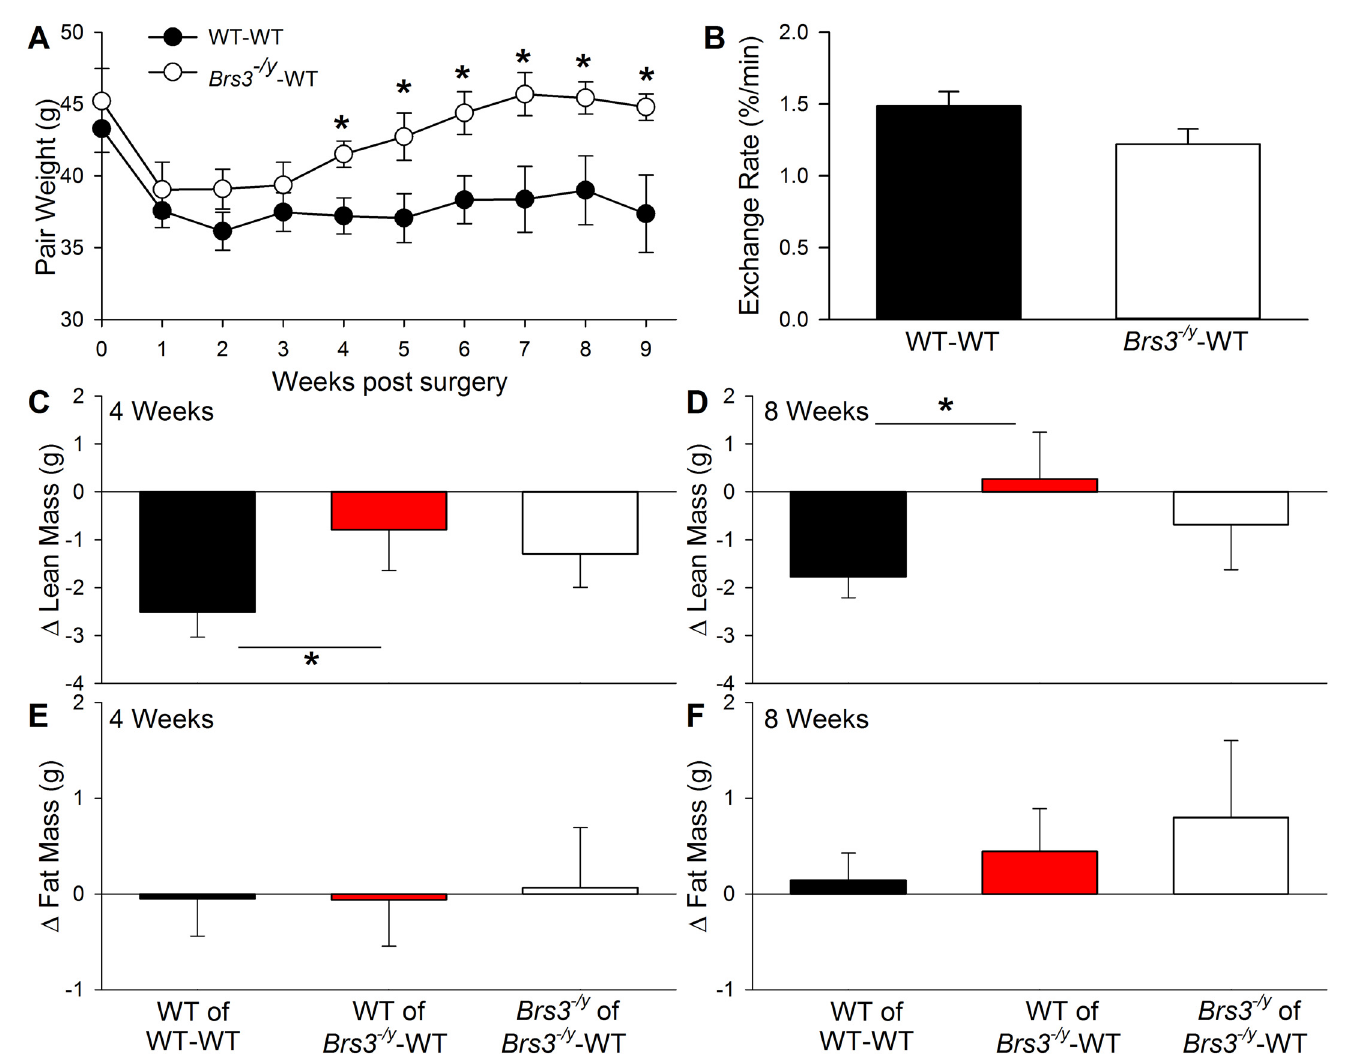
Fig 2. Body weight and composition in parabiotic pairs. (A) Pair weights after parabiosis. (B) Circulatory exchange between parabiotic mice at 7 weeks after surgery, determined by Evans blue transfer. Change after parabiosis in (C, D) lean mass and (E, F) fat mass at 4 or 8 weeks after surgery. Data are mean ± SEM; N = 7 – 8 pairs/group. * P <